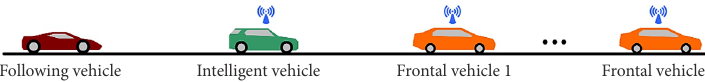
Figure 2. Problem of rear-end collision escape (source: created by the